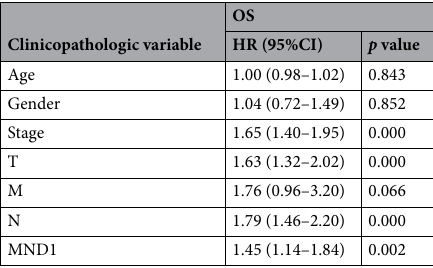
Table 3. Correlations of OS with clinic-pathologic characteristics in LUAD patients estimated using multivariate Cox regression analysis. OS overall survival, HR hazard ratio, 95%CI 95% confidence interval.